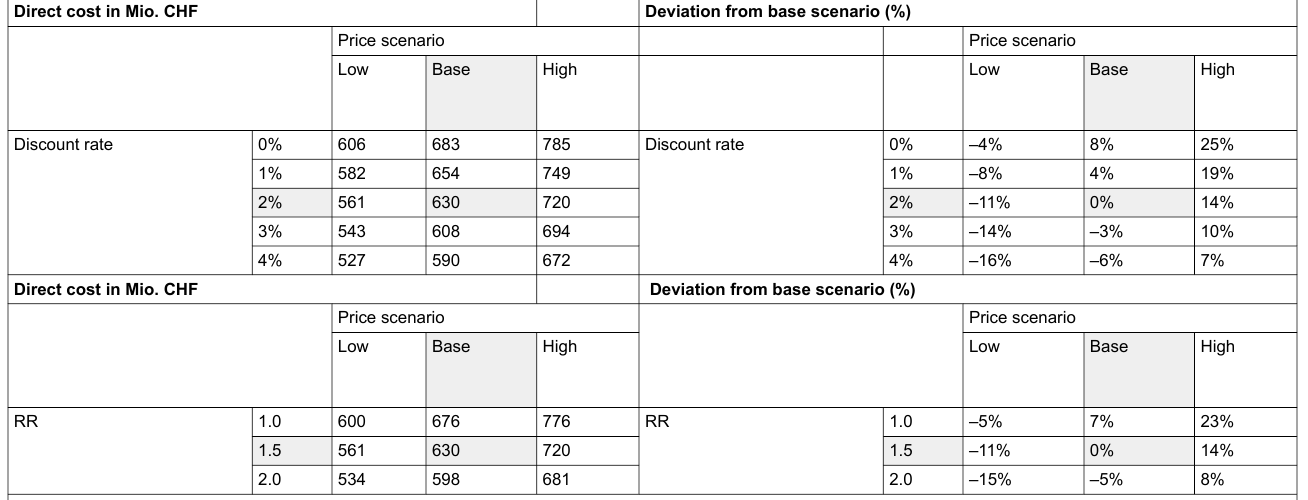
Table 8: Results of sensitivity analysis on direct costs. Assumed factor for increased relative risk of mortality: 1.5; assumed discount rate: 2%. Direct cost in Mio. CHF